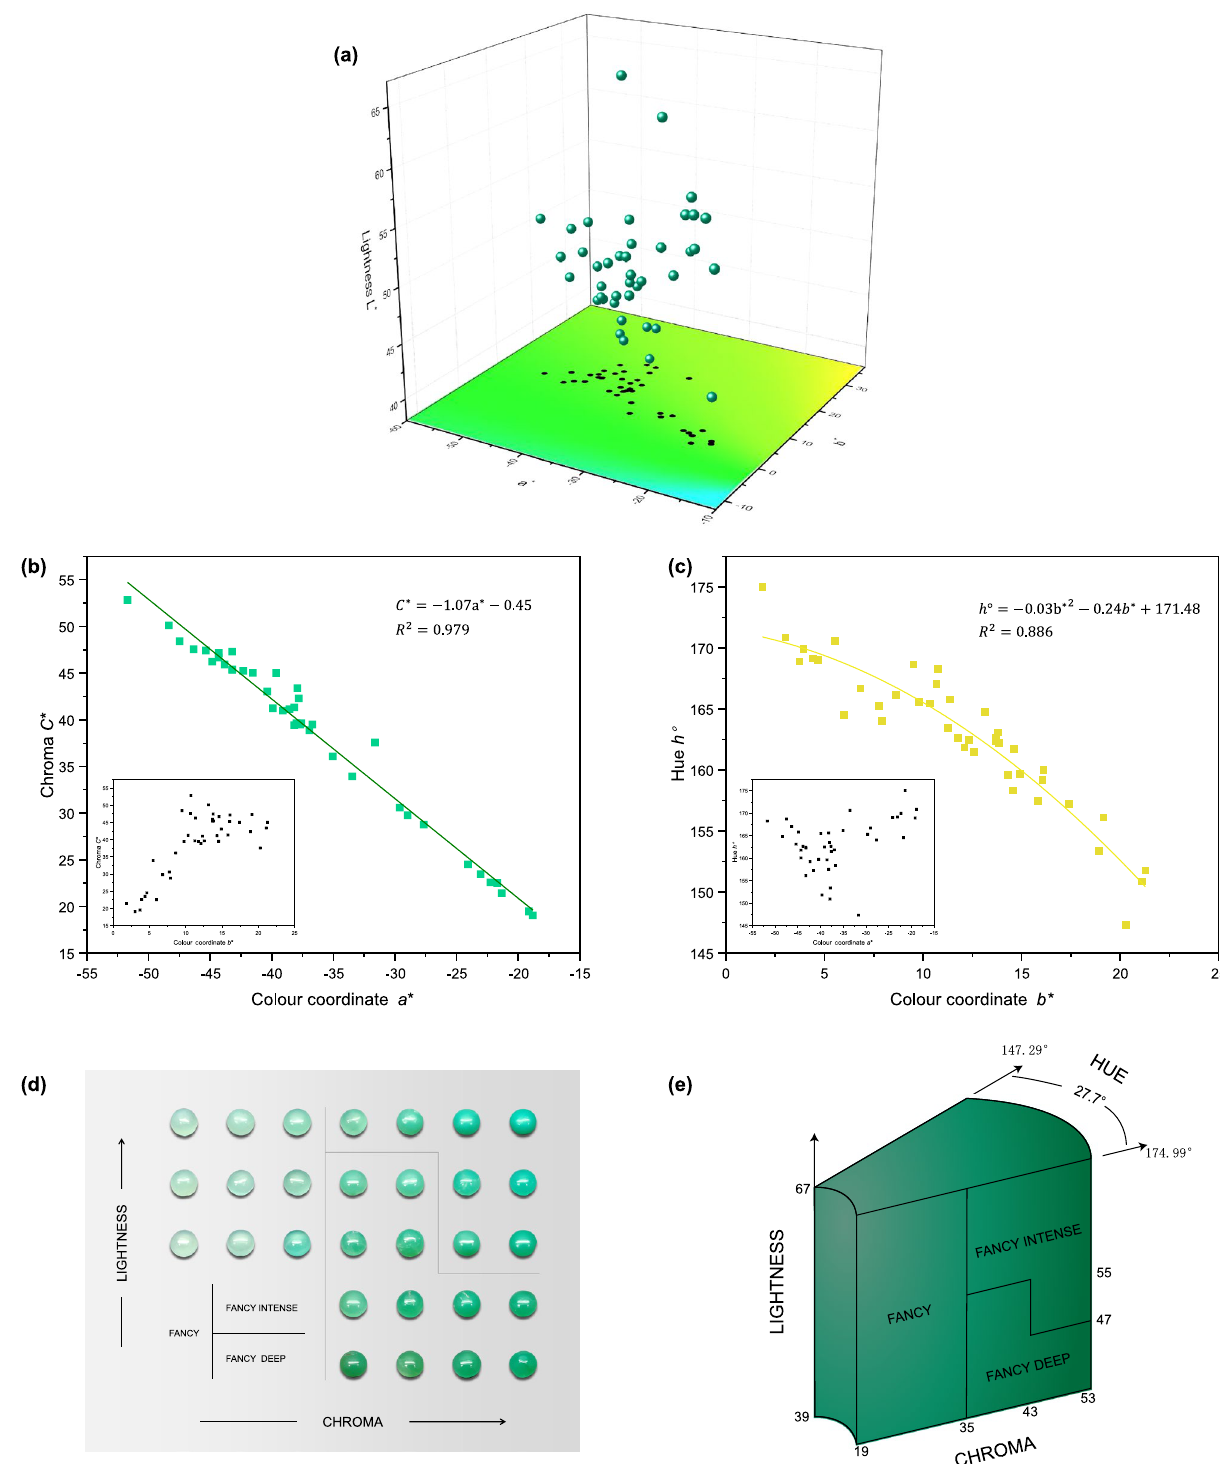
Figure 2. The colour analysis of chrysoprase. ( a ) 41 chrysoprase green plots in CIE 1976 L * a * b * uniform colour space. ( b ) A high negative correlation between the colourimetric coordinate a * and its chroma C * . ( c ) A high negative correlation between the colourimetric coordinate b * and its hue angle h °. ( d ) Chrysoprase colour is graded into the levels of fancy, fancy intense and fancy deep. ( e ) Chrysoprase colour grading